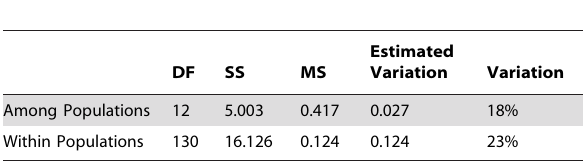
Table 2. AMOVAs of genetic subdivision in modern northern Yellowstone based on the four identified mitochondrial